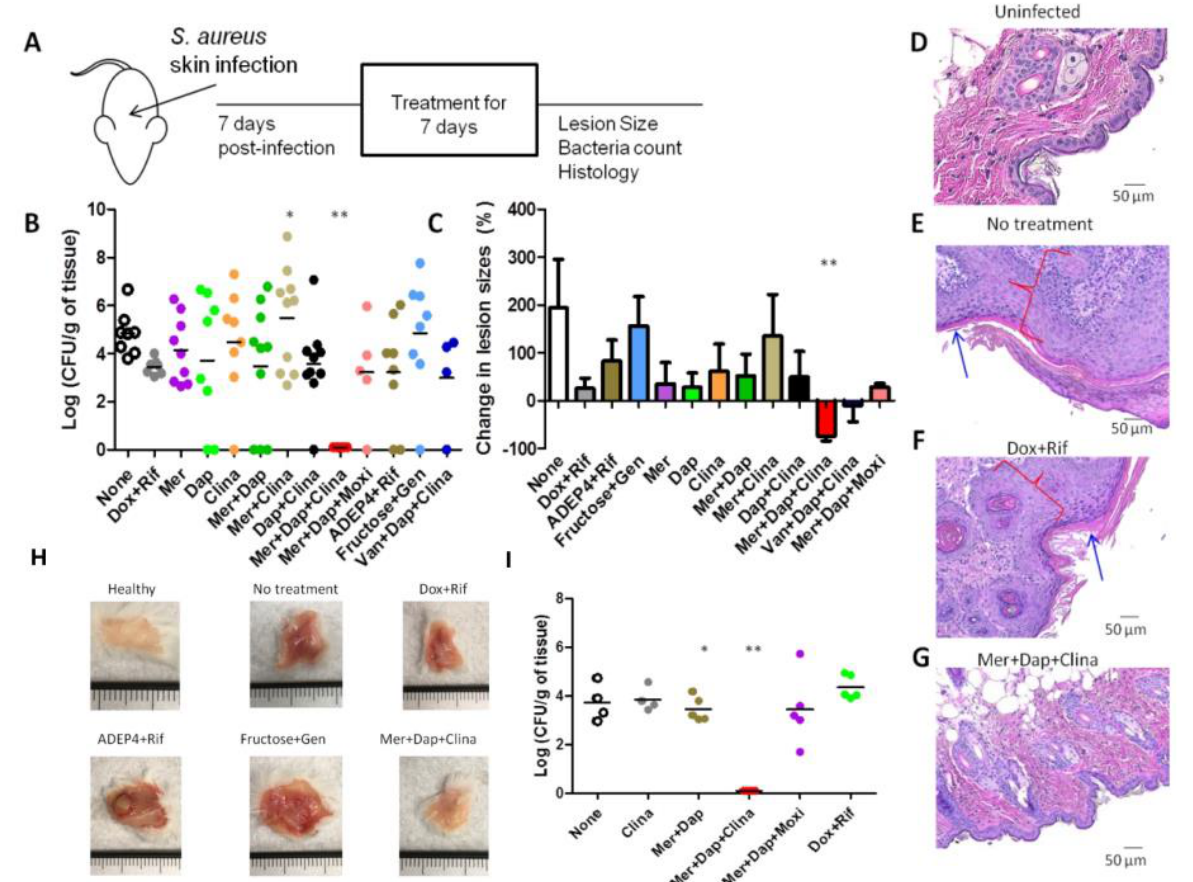
Figure 5. Validation of drug combinations in a chronic skin infection model established with S. aureus USA300 biofilm bacteria. ( A ) Study design of mouse treatment studies. ( B ) Bacterial load in the skin lesions. ( C ) Changes in lesion sizes and histology of skin tissues of mice infected with USA300 biofilm bacteria and treated 7-days with drug combinations and respective controls were measured.